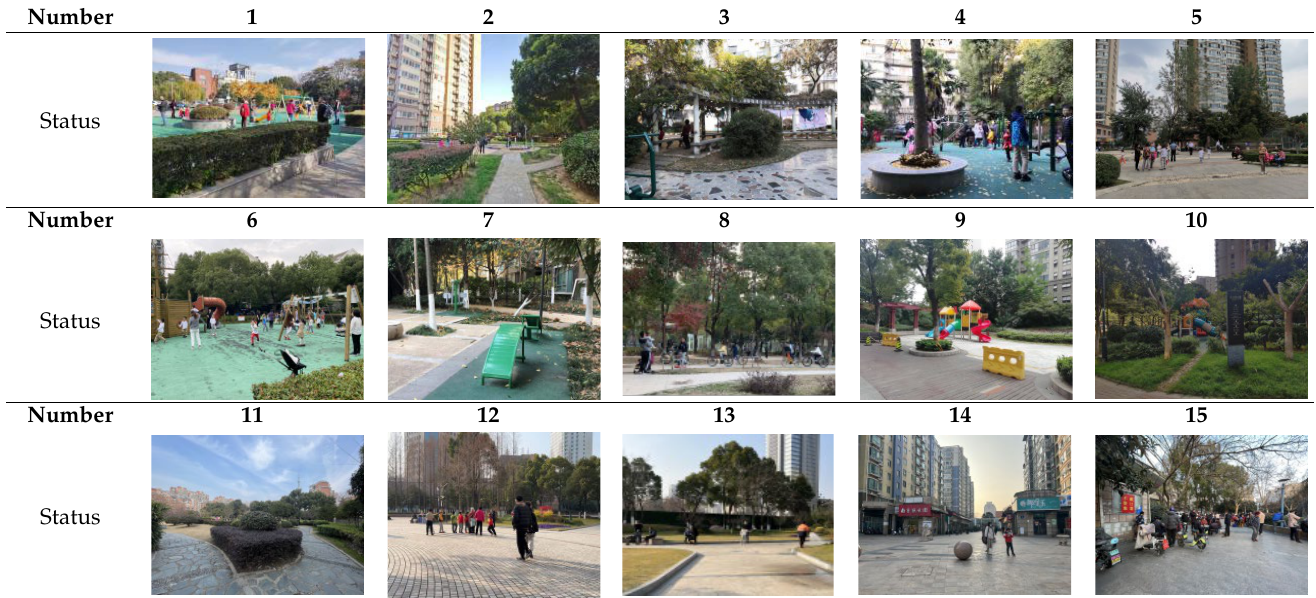
Figure 2. Locations of sample residential neighborhoods in Longjiang Region. Table 1. Pictures of the sample residential neighborhoods.